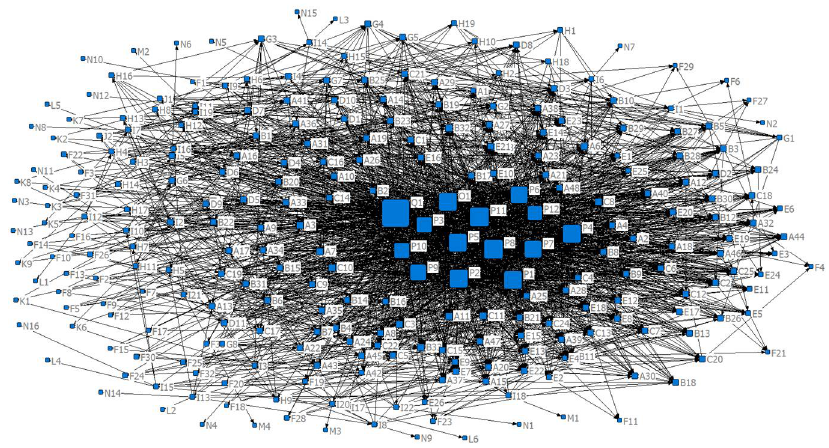
Figure 6. Inter-actor market relationship network of ecological agriculture. Table 1. List of the classifications of ecological agriculture actors and the subtypes of each actor group.